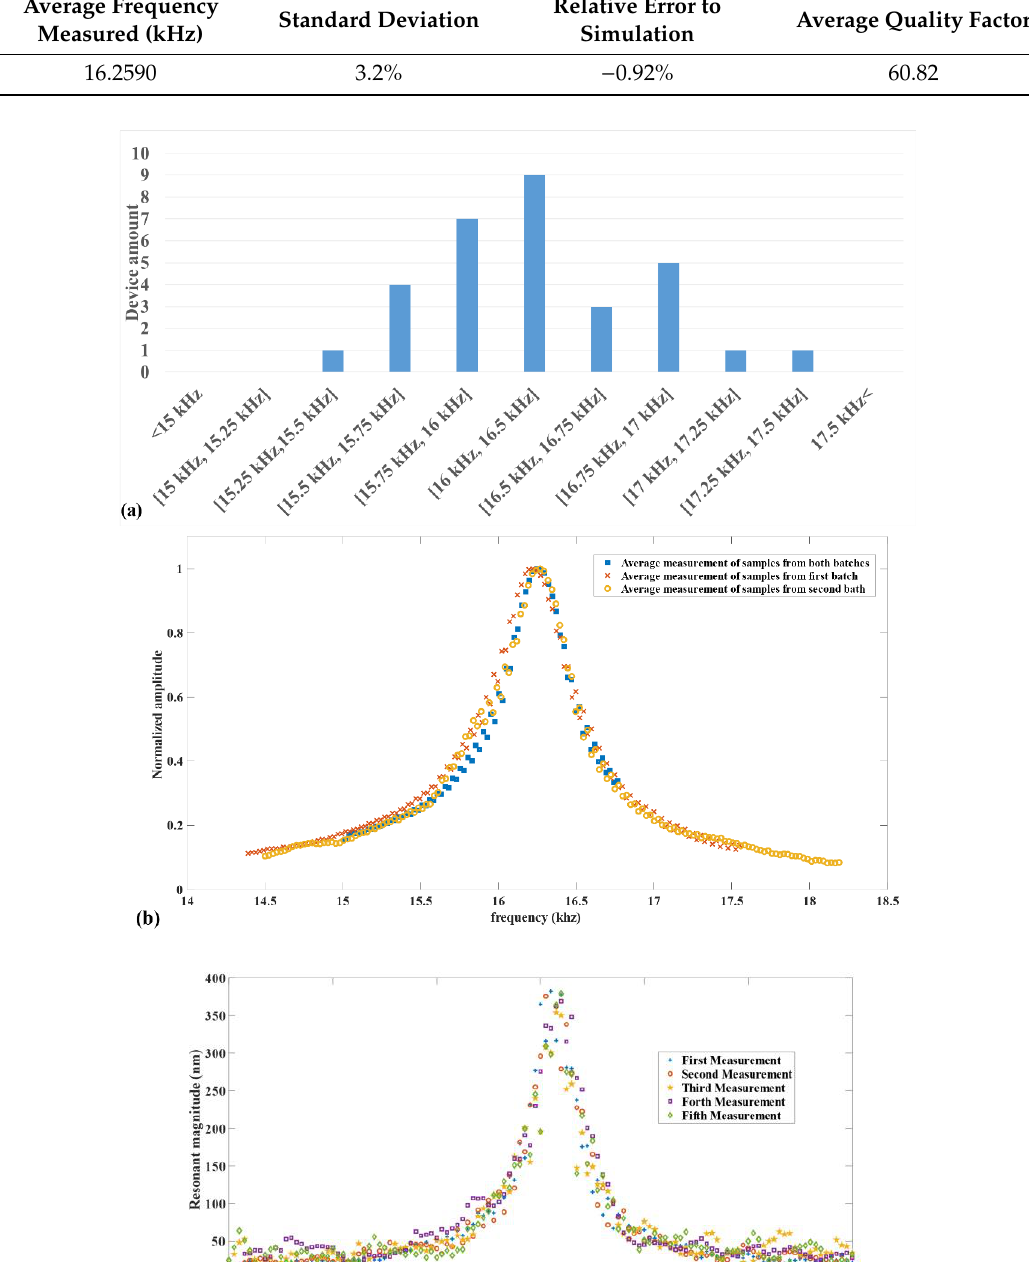
Table 3. Statistical information of the measurement result for mechanical resonance.